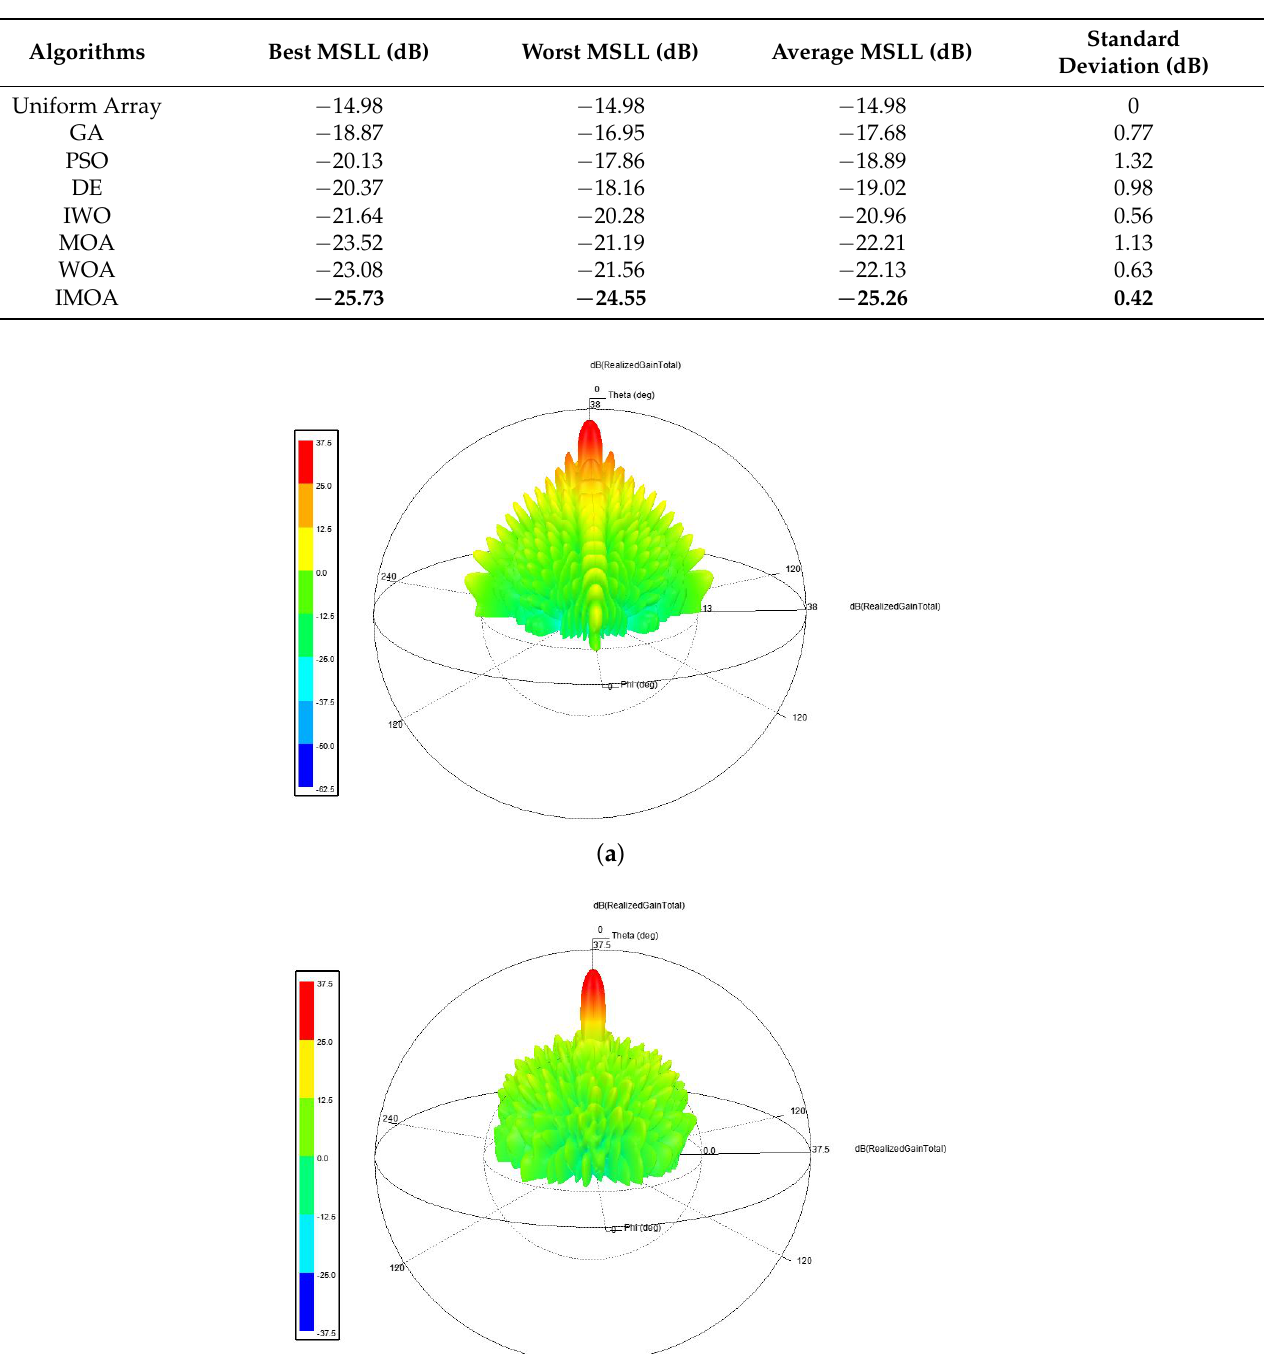
Table 4. Results of algorithms on basic benchmark functions.